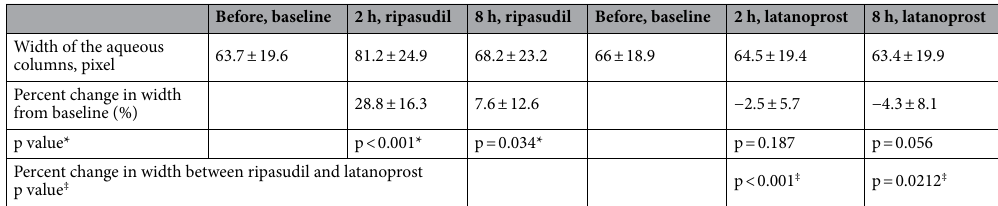
Table 2. Comparison of mean width of aqueous column. *Within-group comparison to baseline. ‡ Between group